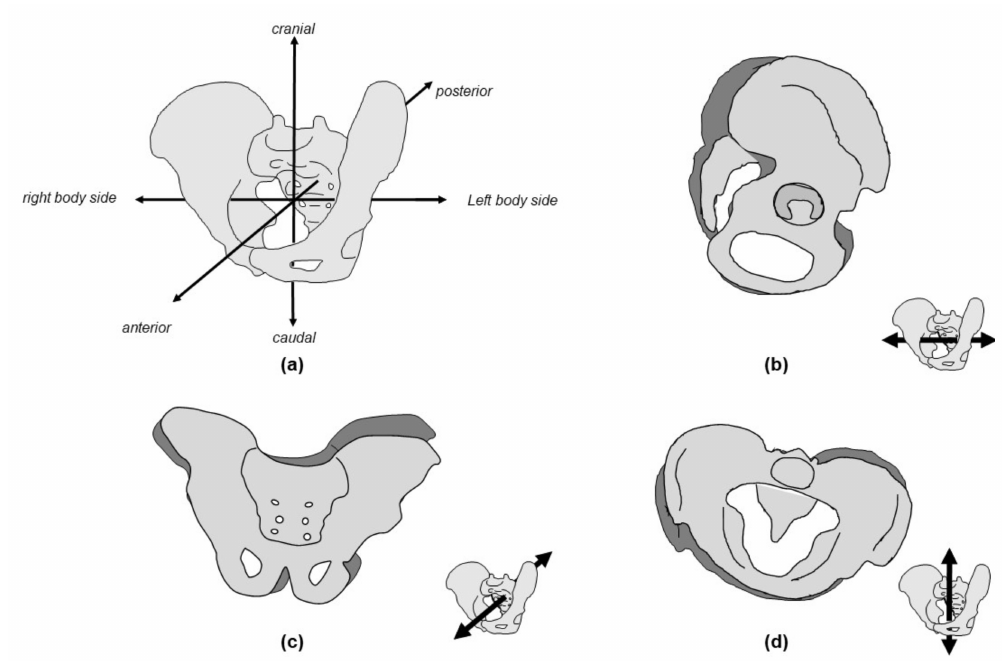
Figure 3. Pelvic model element and its alignment options. ( a ) Local coordinate system based on an anatomical axis of the pelvic model element. ( b ) Anterior/posterior inclination up to ± 5 deg of so-called pelvic tilt, presenting a motion within the sagittal plane, representing rotation around the medio-lateral axis. ( c ) Lateral inclination up to ± 5 deg of so-called pelvic obliquity, presenting a motion within the frontal plane and rotation around the anterior-posterior axis. ( d ) Pelvic rotation up to ± 5 deg, presenting a motion within the transverse plane and rotation around the cranio-caudal